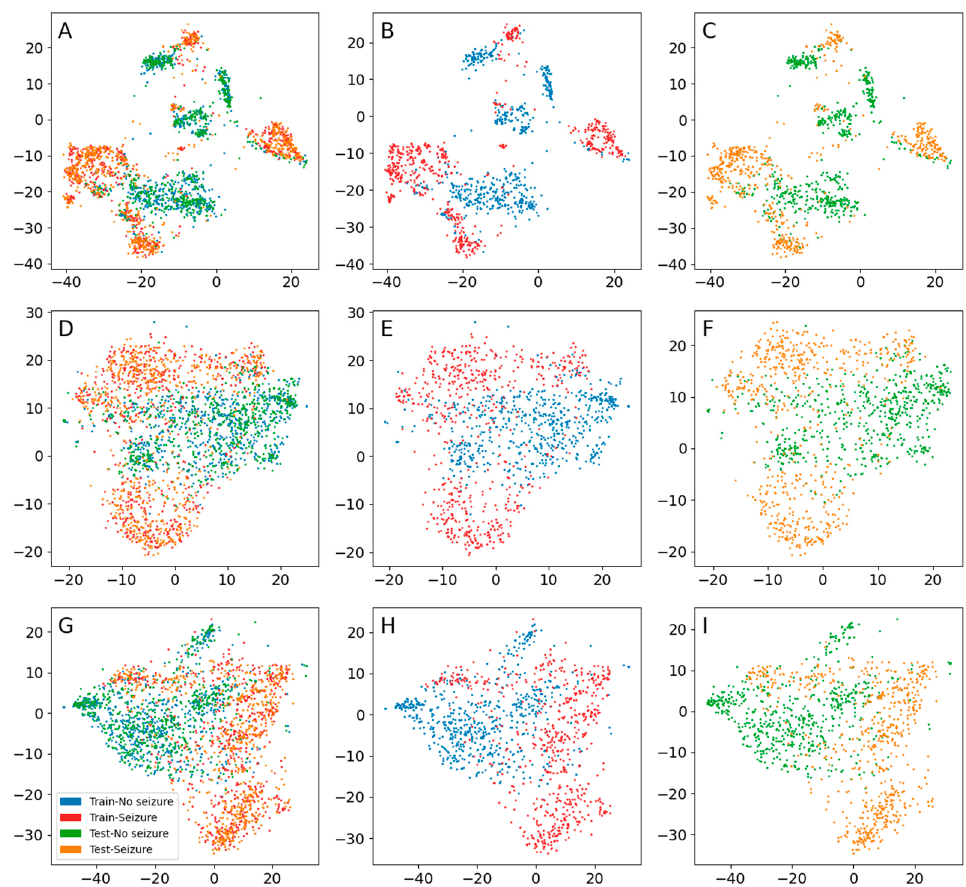
Figure 6. Low-dimensional representations of the seizure dataset. Each dot represents 1 s of data. First row ( A – C ): CNN. Second row ( D – F ): STFT. Third row ( G – I ): CWT. First column ( A , D , G ): all data. Second column ( B , E , H ): training data. Third column ( C , F , I ): test data. Table 4. Quantitative measures for the seizure dataset. Significantly higher values in a column are in bold (chi-square test). κ indicates the kappa value for SVM; L indicates a linear kernel; R indicates a radial basis function kernel; C indicates the number of clusters by k-means.